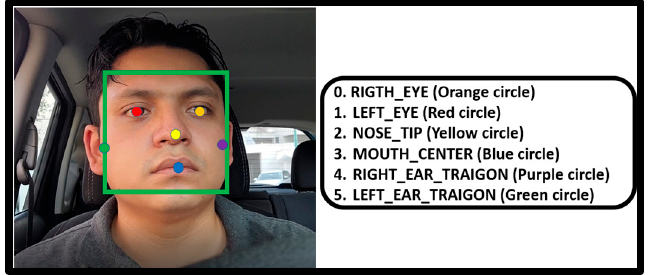
Figure 4. Reference points used to detect a face region using the MediaPipe face detection.